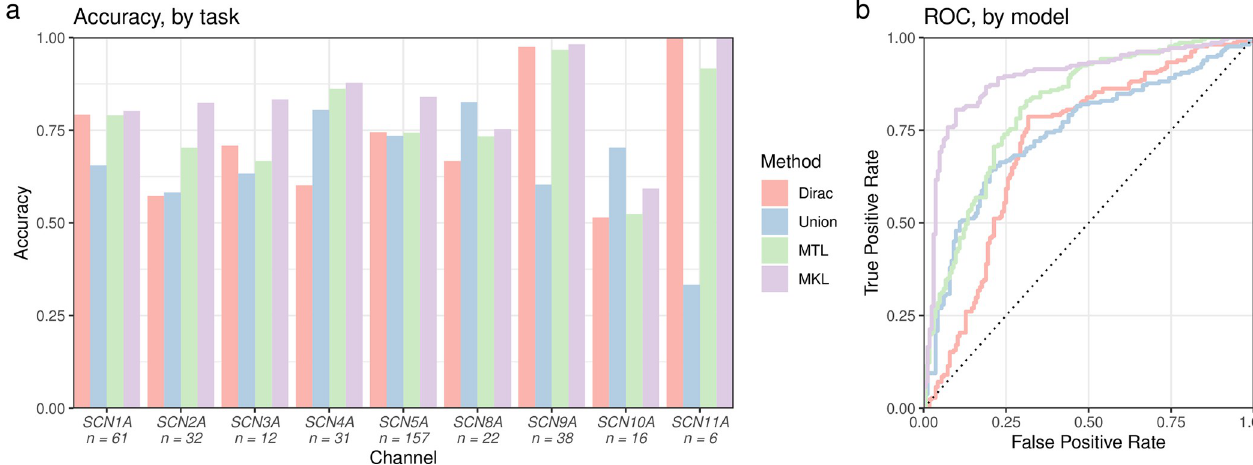
Fig 1. Phenotypic multi-task multi-kernel learning outperforms both conventional and state-of-the-art models. a: Cross-validation model performance estimates of mean accuracy for each task (channel). b : ROC curves. The AU-ROC for each model is shown in Table 1. Abbreviations: MTL–multi-task learning; MKL–multi-kernel learning; ROC–receiver operator characteristics.